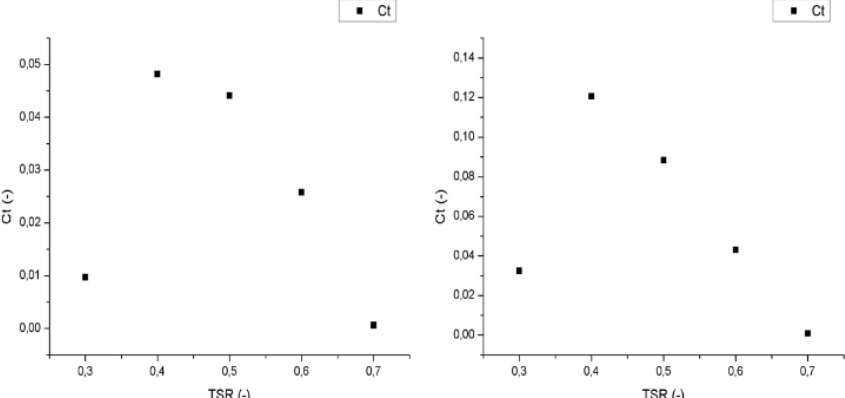
Figure 13: Graph of correlation a) C p with TSR and b) C t with TSR on Rotor Three Stage 0 ∘ .